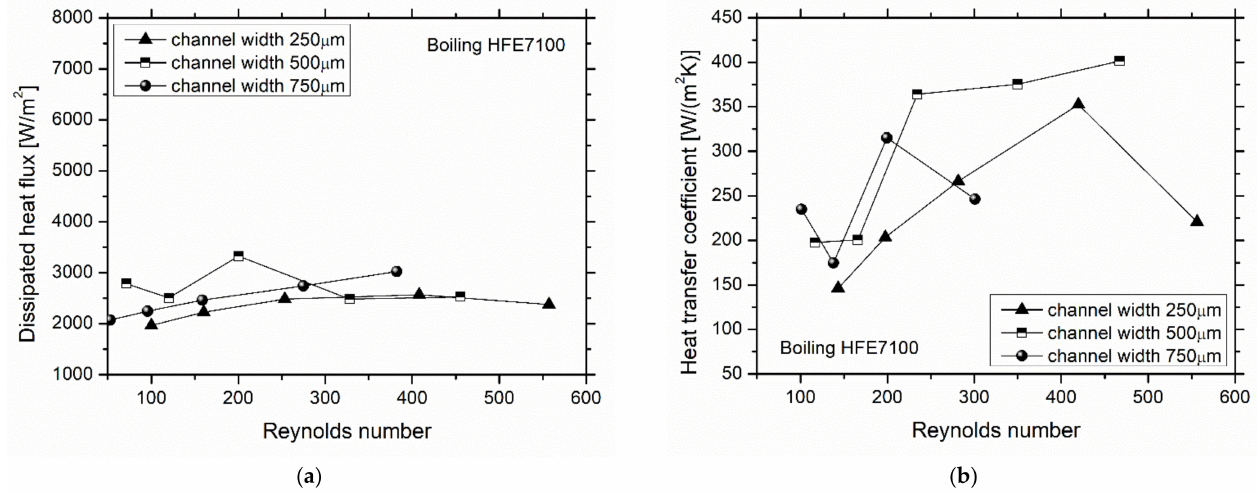
Figure 6. ( a ) Dissipated heat flux and ( b ) heat transfer coefficient of the boiling HFE7100 flow in the heat sinks with varying wall